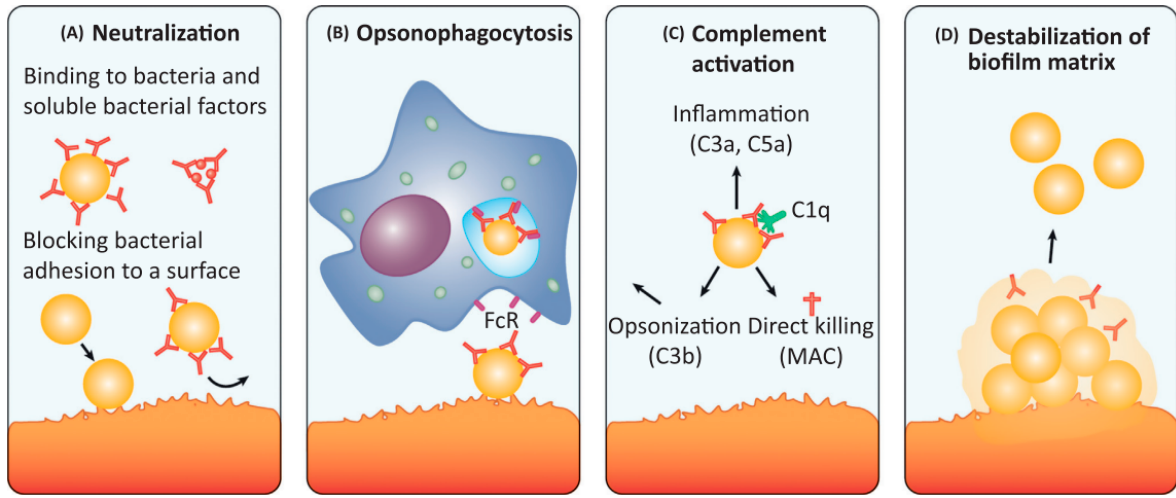
Figure 3. The antibodies against biofilm can disrupt ongoing biofilm formation and/or disperse established biofilms by different mechanisms: ( A ) neutralisation, ( B ) opsonophagocytosis, ( C ) complement activation and ( D ) destabilisation of biofilm matrix. Adapted with permission from Raafat et al. [42]. 2019, Elsevier.